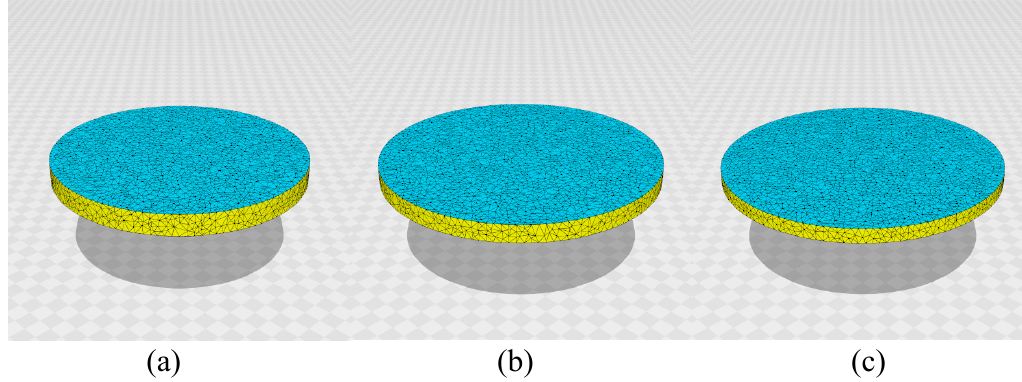
Figure 2. 3D disks of three di ff erent ratios D / H with diameter D and thickness H . The ratio D / H and the total number of vertices N are ( a ) D / H = 12, N = 10,566, ( b ) D / H = 16, N = 10,980, and ( c ) D / H = 20, N = 10,563. The scales of the figures are the same. Table 1. The four di ff erent lattices used in this paper. The first lattice of size N = 10,346 is used only for the calculation of Gaussian